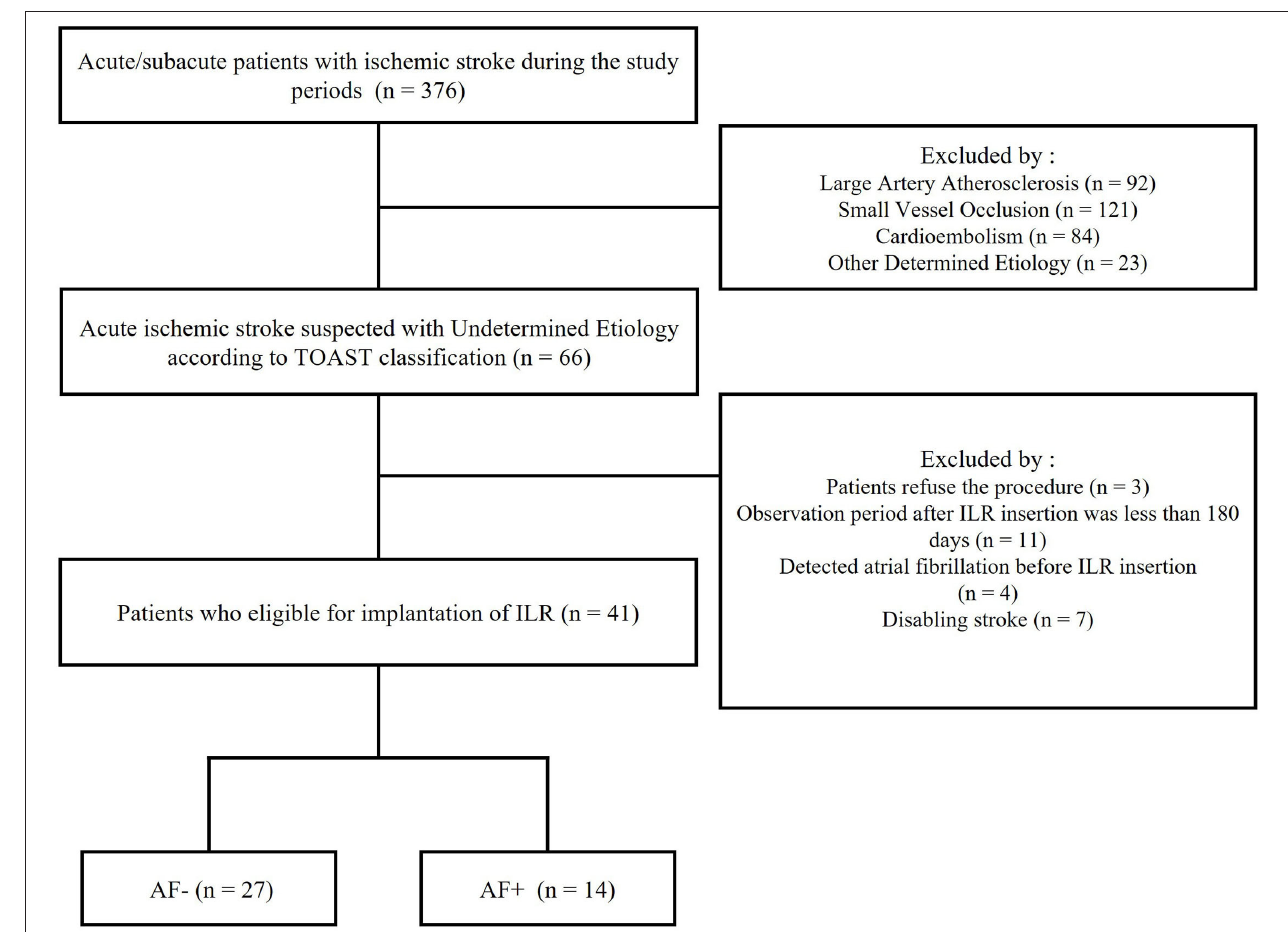
FIGURE 2 | Flowchart of the Patient selection